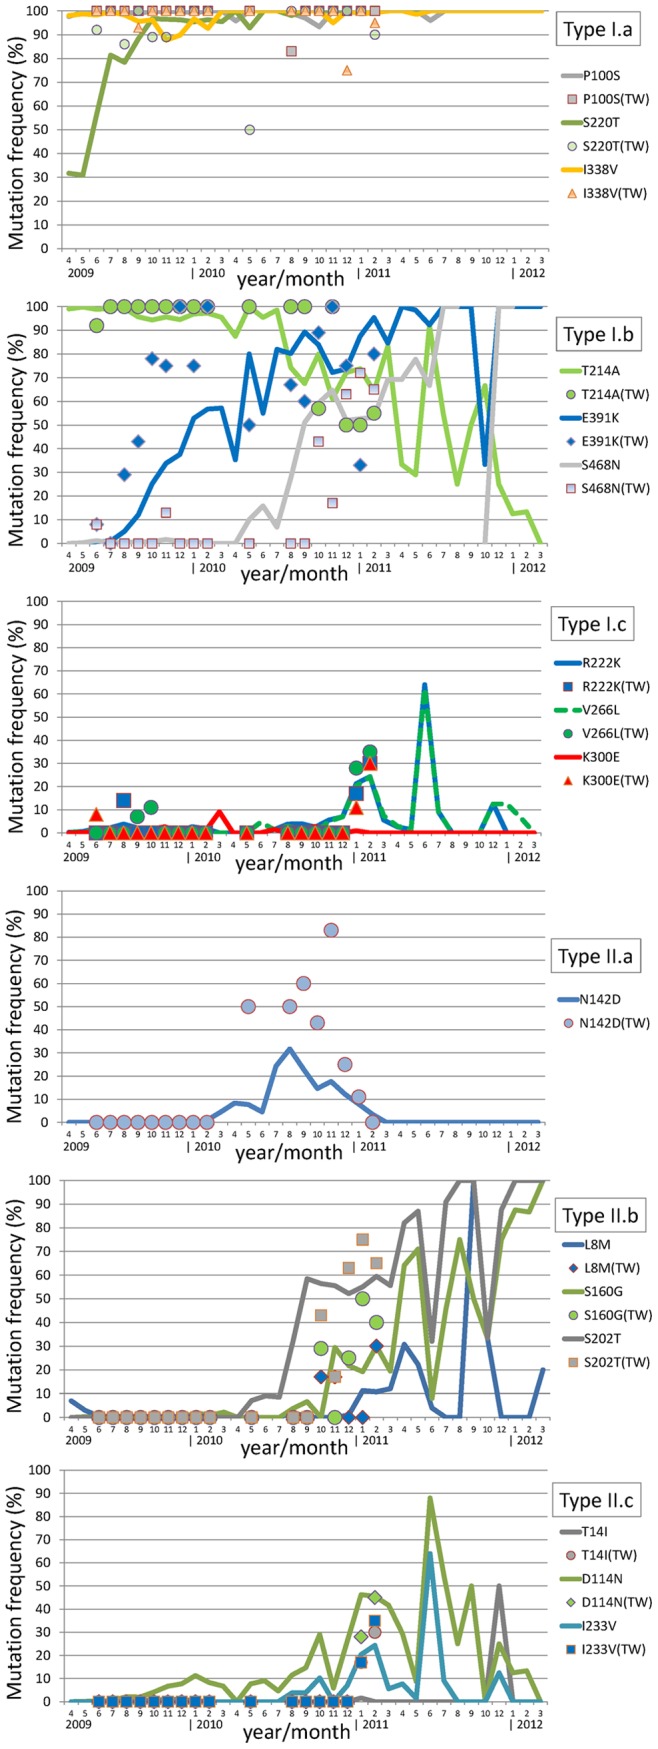
HA mutation dynamics of Taiwanese H1N1pdm viruses versus publicly available H1N1pdm viruses.Horizontal axis represents the year/month the sampling took place, and the vertical axis represents the frequency (in percentage) that one particular mutation occurred in the month. Taiwanese data range from June 2009 to February 2011, and are graphed by various markers (circles, squares, triangles, and diamonds). A total of 8,876 H1N1pdm HA sequences are collected from NCBI which cover a 3-year span from April 2009 to March 2012 (no case in April 2012), and are graphed in thick lines. Mutations are grouped according to the transitioning types described in Table 1, and are displayed from top to bottom as type I.a, I.b, I.c, II.a, II.b and II.c. Note that some lines are broken due to that no samples are found in these months. Various lines may have different breakpoints since some NCBI sequences are partial, making total positional counts vary. For example, there is no amino acid 468 (shown in a gray line in the second subpanel) available in September 2011, as well as in February and March of 2012.